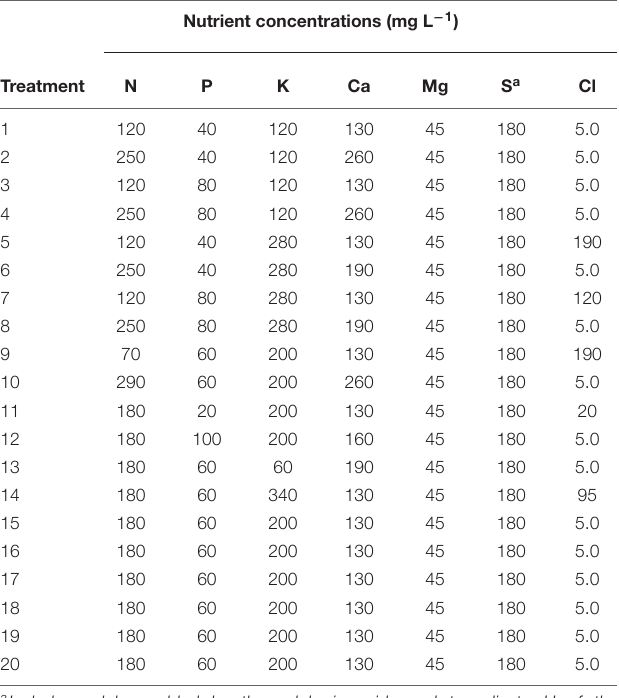
TABLE 4 | Composition of major anions and cations in the treatment nutrient solutions.